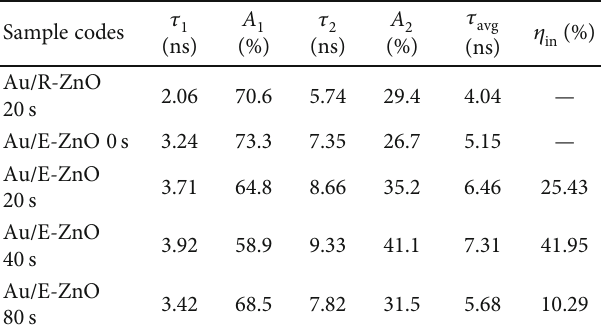
Figure 14: Normalized time-resolved PL decay spectra of the Au/R- ZnO 20 s and Au/E-ZnO Schottky-heterojunction nanocomplex for Au NPs with di ff erent deposition times: 0 s, 20s, 40s, and 80s, at the wavelength of 390 nm, respectively. Table 2: Fast and slow decay times along with their amplitudes, average lifetime ( τ ), and carrier injection e ffi ciency ( η ) for avg in Au/R-ZnO and Au/E-ZnO Schottky-heterojunction nanocomplex with di ff erent Au NP deposition times,